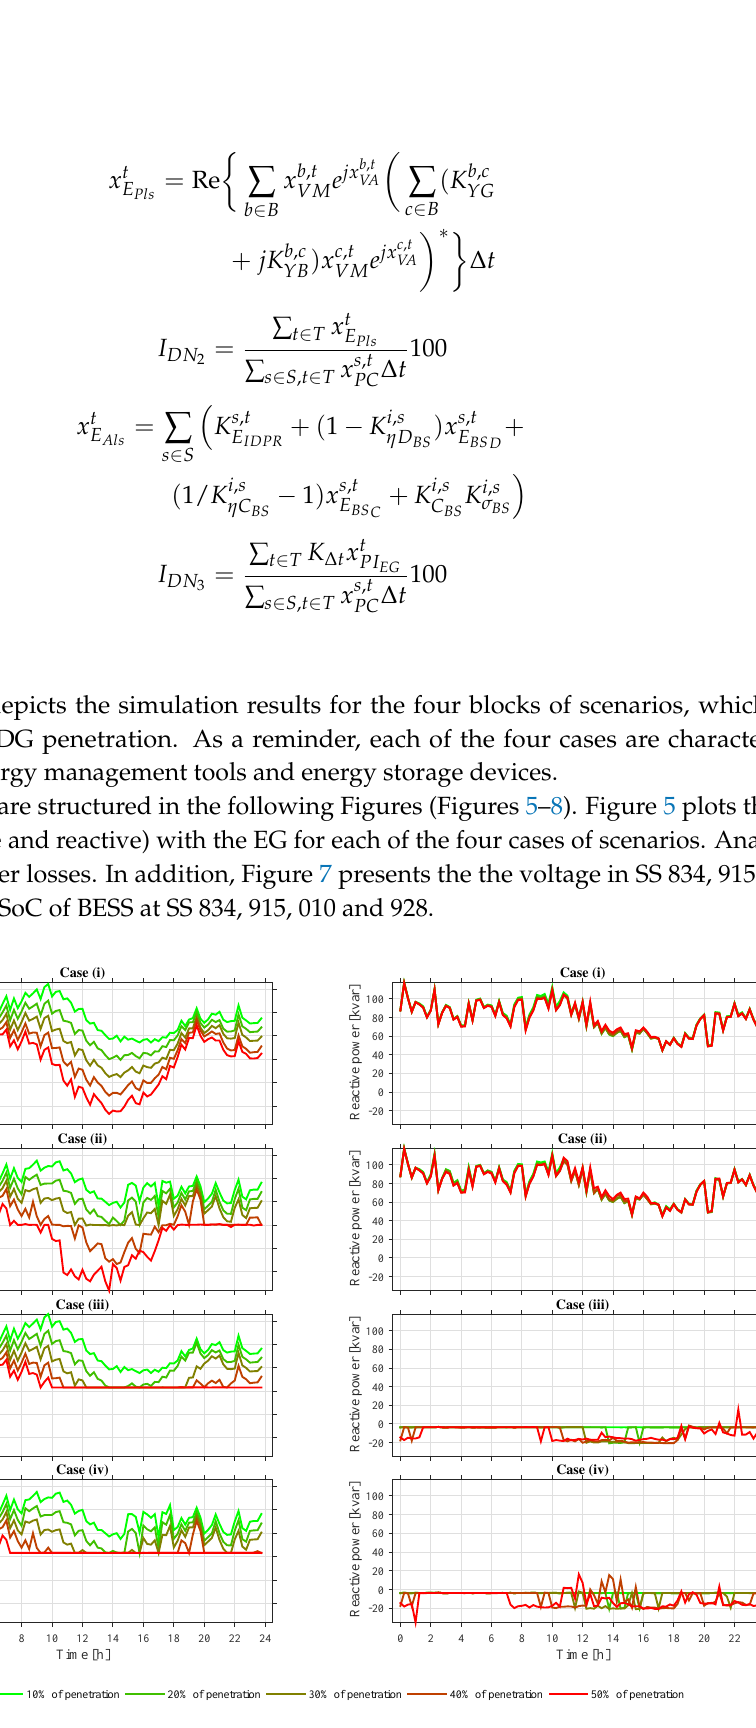
Figure 5. Active and reactive power exchanged with the EG (first and second column, respectively) for each block (rows) and for all penetrations (colour scale, legend depicted in Figure